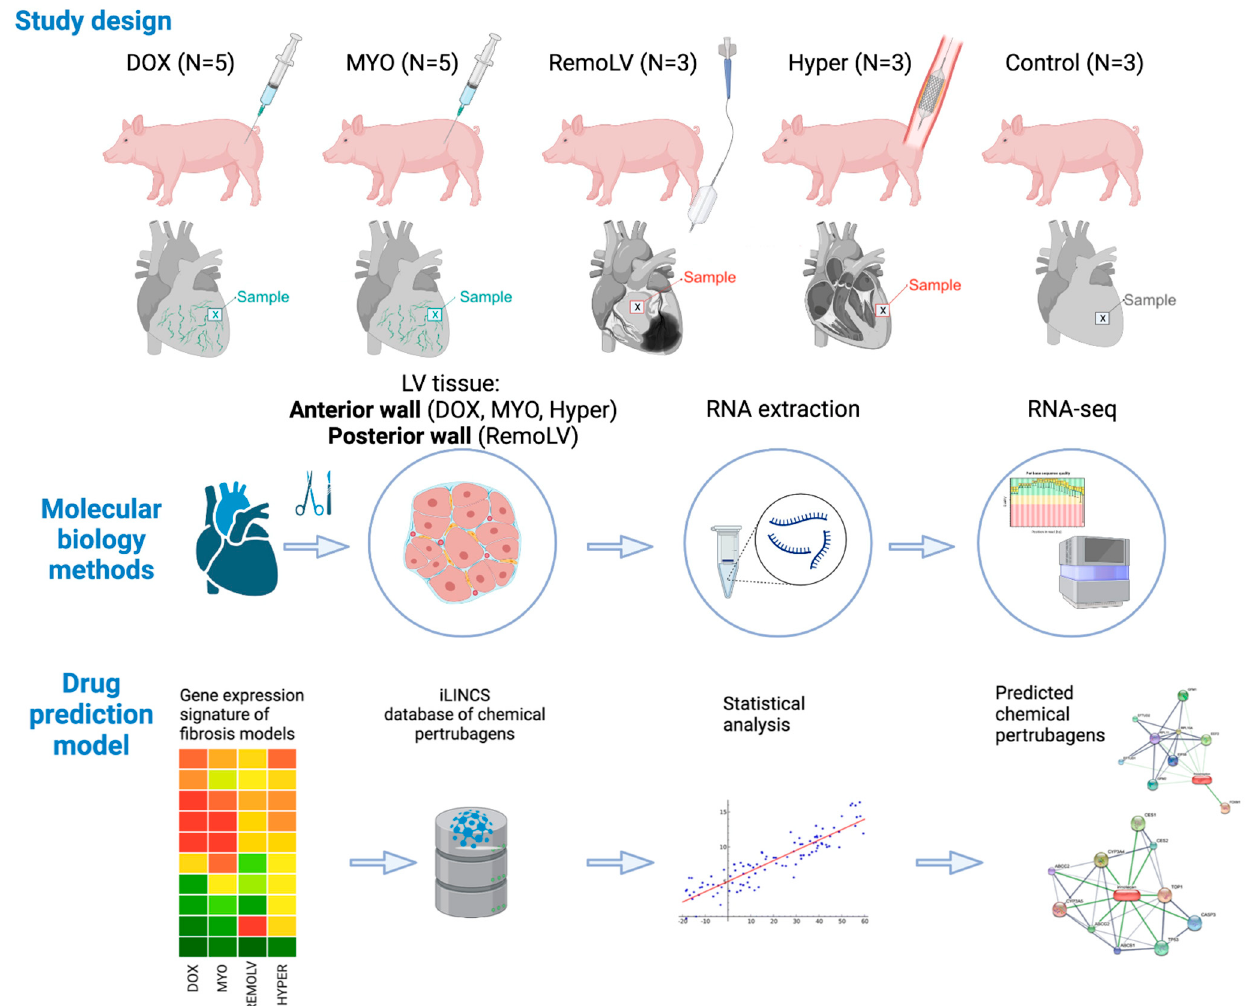
Figure 6. Study design and applied molecular biology methods. The study population comprises 5 groups of pigs. DOX animals (N = 5) received doxorubicin and MYO animal (N = 5) Myocet ® infusions in doses equivalent to human treatment regimens. Catheter-based reperfused anterior wall myocardial infarction was induced by balloon inflation in mid-LAD, and induced adverse remodeling of the enlarged left ventricle (LV), resulting in volume-overload myocardial fibrosis of the posterior non-ischemic wall (RemoLV, N = 3). Artificial aortic isthmus stenosis was designed to study pressure overload-induced myocardial remodeling (Hyper, N = 3). Sham interventions served as control (Control, N = 3). After a pre-defined follow-up (FUP), the hearts were explanted and subjected to RNA expression analysis following RNA-seq bioinformatics pipeline and drug prediction model. Graphical elements in both panels were created with BioRender.com.